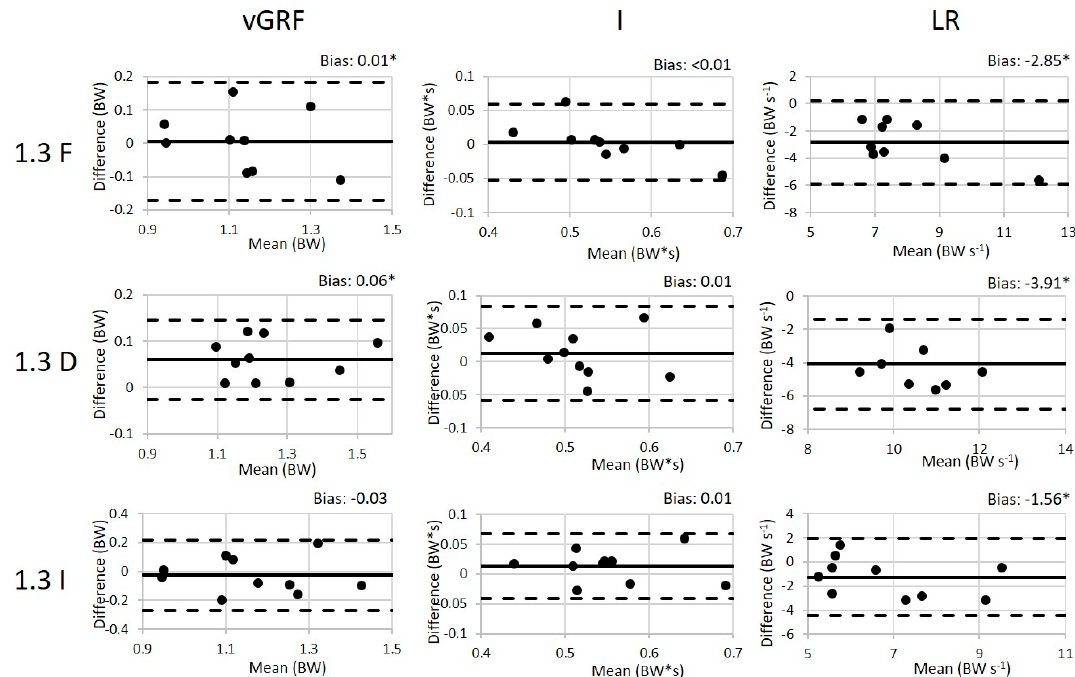
Figure 6. The Bland–Altman plots for walking conditions (1.3 m/s, flat (F), inclined (I), and declined (D)) with the 200 Hz loadsol ® . The difference is calculated by subtracting the loadsol ® values from the force plate values. The bias is displayed for each variable with a * indicating a statistically significant difference between the force plate and loadsol ® .